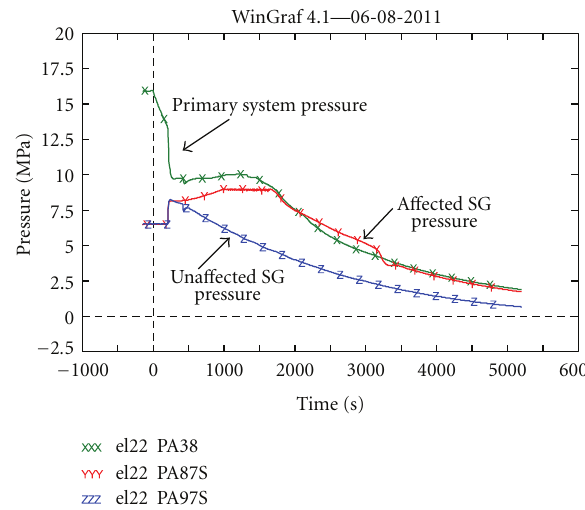
Figure 7: Primary system pressure and HPIS/PORV flow during a loss of feed water with bleed and feed. Figure 8: Primary and secondary system pressures in a 0.4% steam generator tube